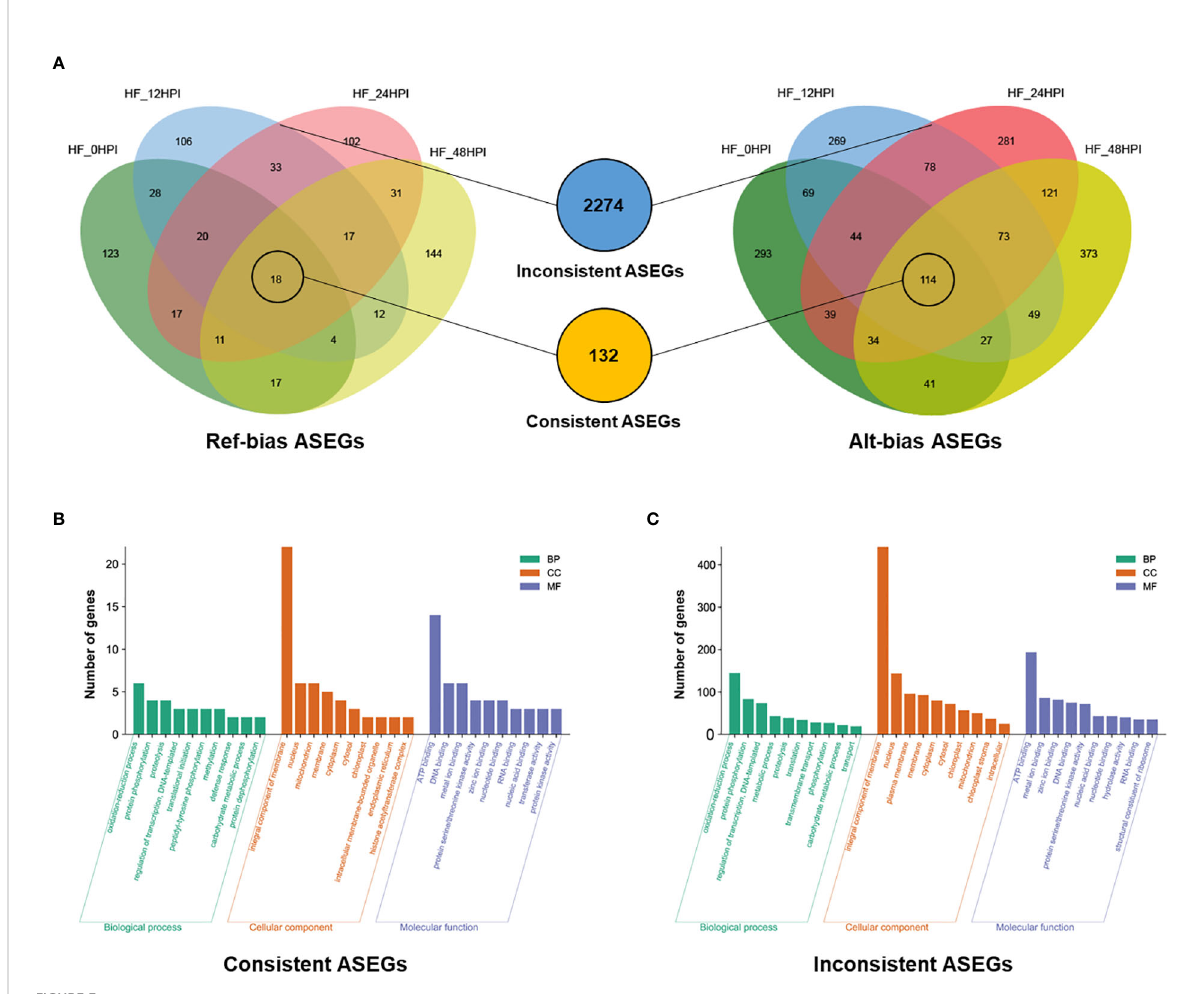
FIGURE 3 Characteristics of the two models of ASEGs. (A) Venn diagram analysis of reference genomic bias (Ref-bias) and alternative genomic bias (Alt- bias) at various times before and after AAAP infection. The middle blue and orange circles indicate inconsistent and consistent ASEGs, respectively. GO enrichment analysis of (B) consistent and (C) inconsistent